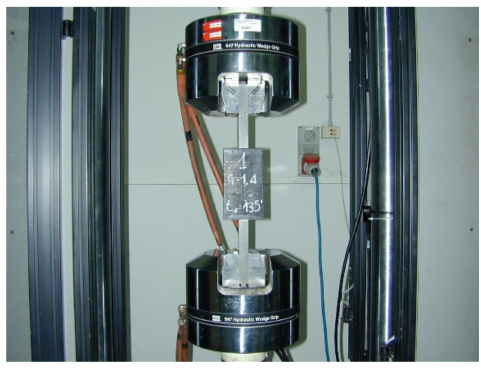
Figure 3. Test setup.